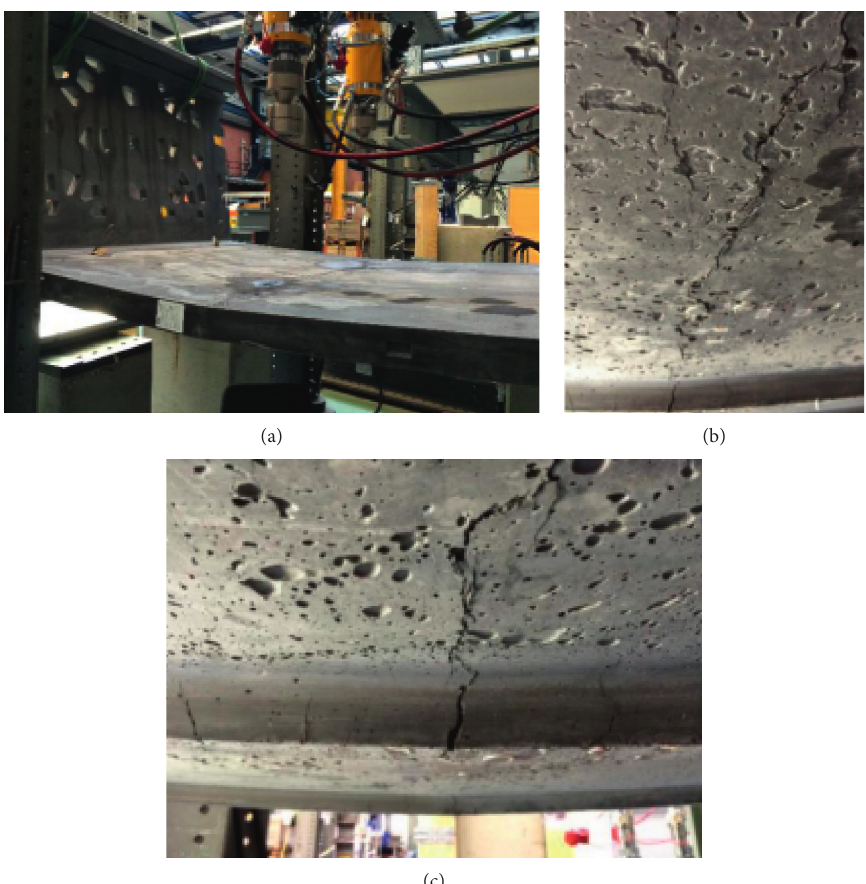
Figure 6: Failure modes of the U-beam test. (a) Top surface failure of the bottom plate (b) Bottom surface failure of the bottom plate. (c) Bottom rib